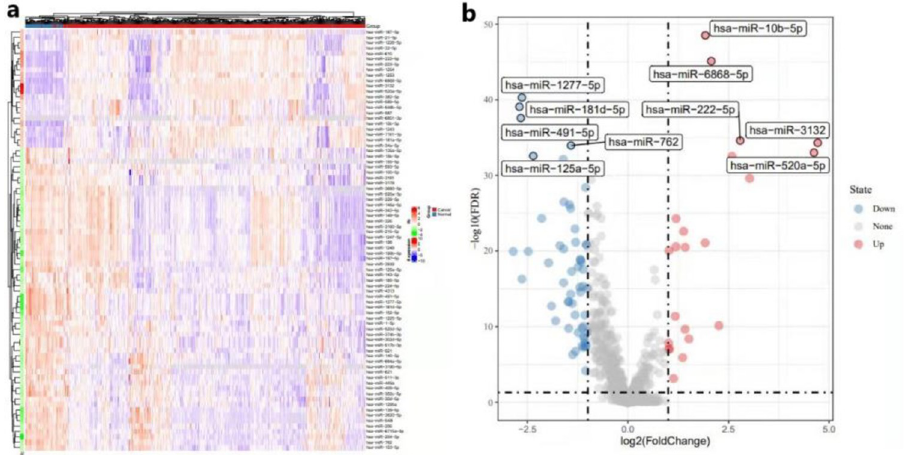
Fig 3. The differential genes expression analysis on miRNA. (a) The overall expression level of miRNA. (b) The volcano diagram about the result of the differential genes expression analysis on miRNA.